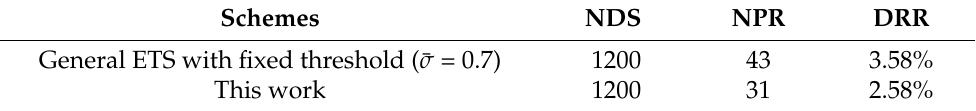
Table 4. The number of packets transmitted in 60 s with sampling period h =